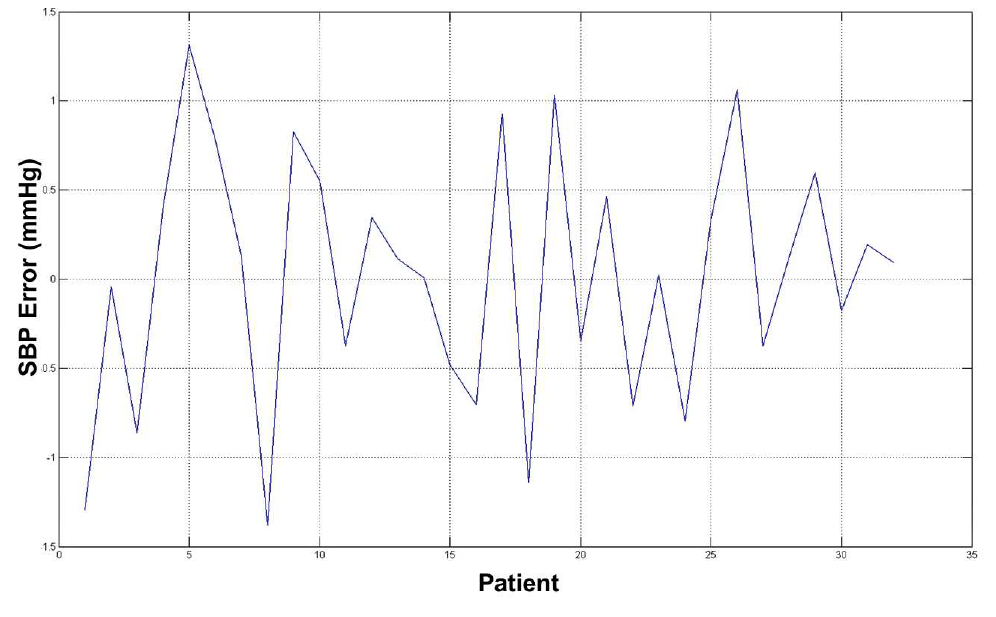
Figure 13. DBP estimation error